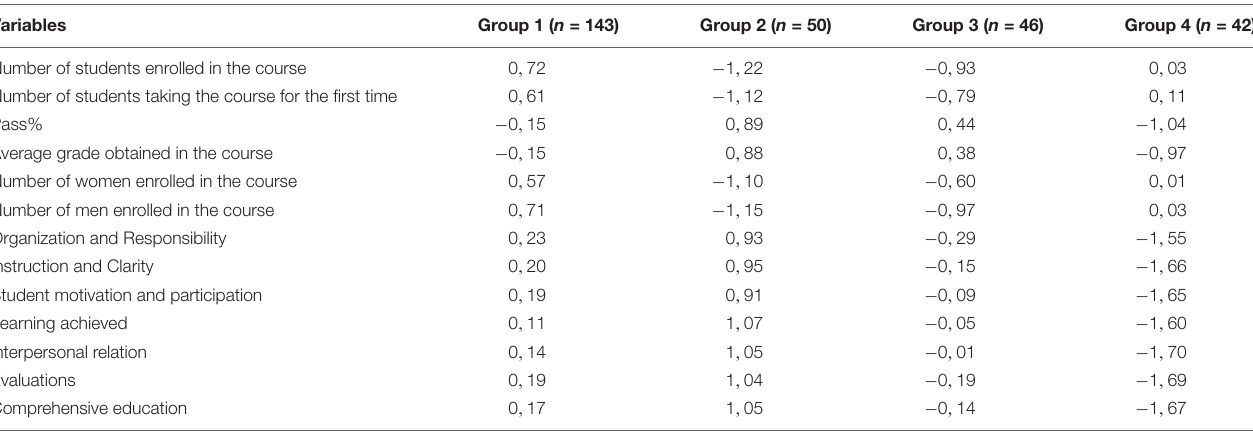
TABLE 2 | Standardized mean scores, in standard deviations, of the variables by the group.